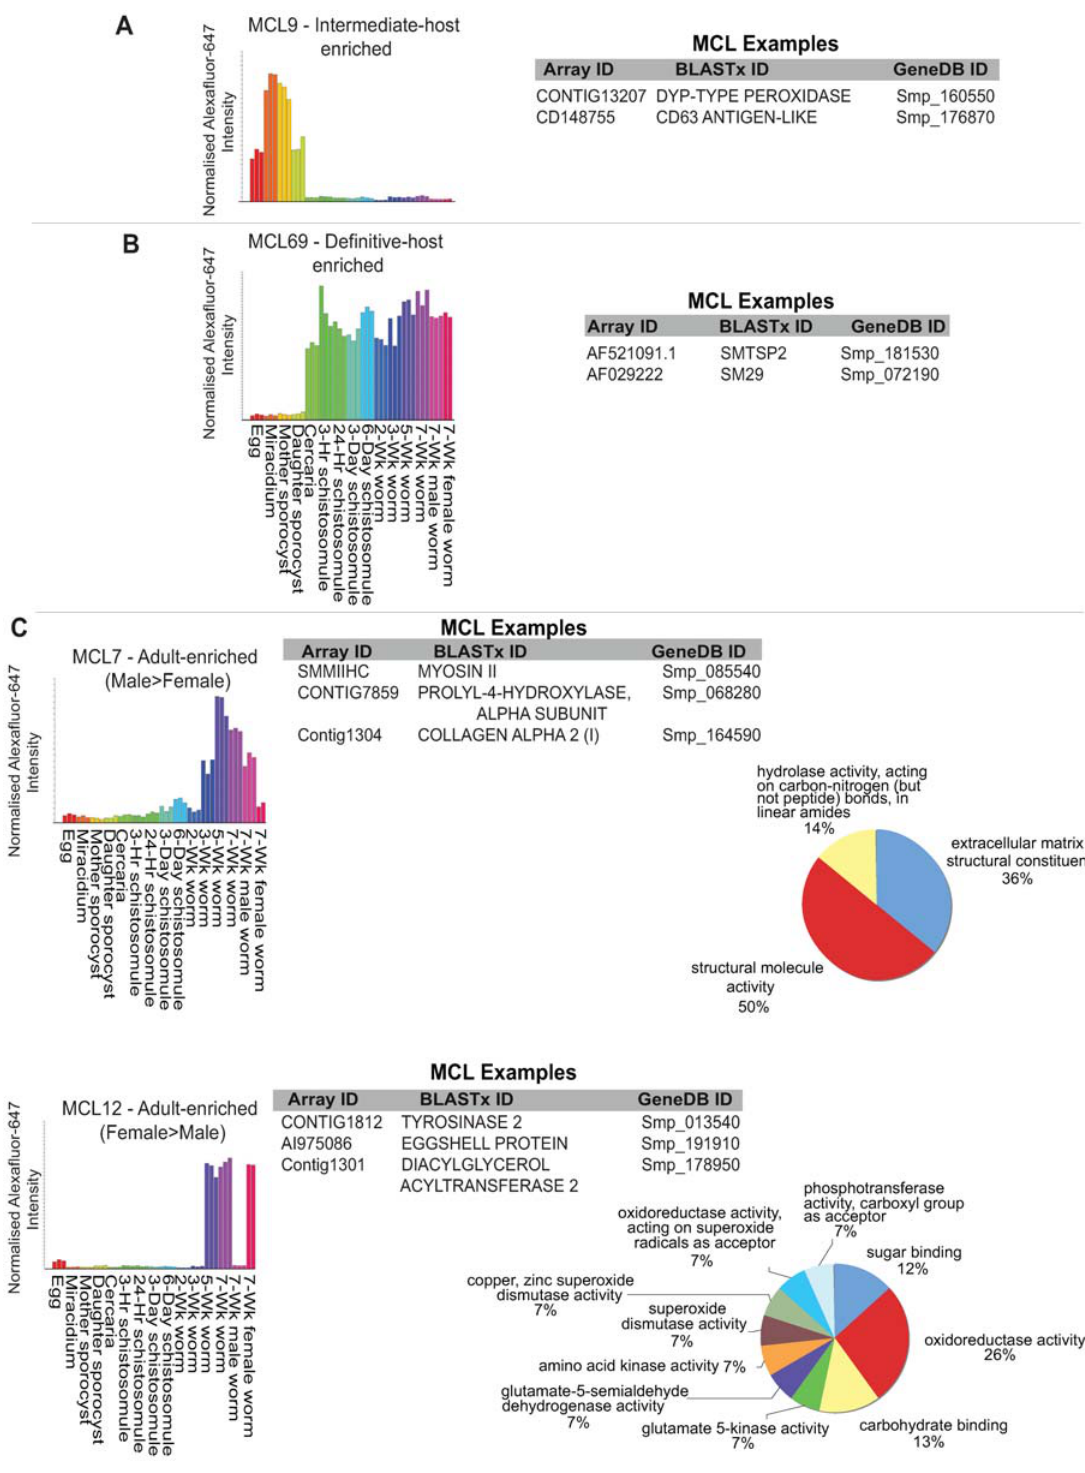
Figure 5. Markov clustering expands the repertoire of differentially expressed transcripts associated with the schistosome dioecious and digenetic state. Network analysis was performed as described in Methods (Pearson correlation, r=0.94 and Markov cluster stringency =1.7). Selected MCLs are included to illustrate transcripts enriched in the intermediate host (A, MCL9), definitive host (B, MCL69) or in adult male and female schistosomes (C, MCL7 - Male . Female; MCL12 - Female . Male). In each case, specific examples of transcripts included in the selected MCLs are listed (full list of transcripts included in each cluster is found in Dataset S6). Enriched Gene Ontology Molecular Function categories are also included where identified. Bar graphs represent average normalised AF647 intensity values (Dataset S4) for all transcripts in that cluster, with replicate values obtained from independent life-stage hybridizations indicated as identical colours.